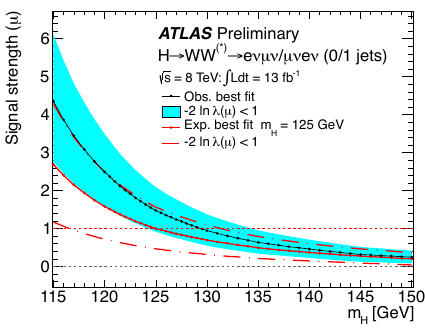
Figure 4. Fitted signal strength parameter ( µ ) as a function of m H for the low mass range [5]. The expected result for an injected signal with m H = 125 GeV (continuous red line) is included for comparison. The uncertainty on µ corresponds to the two cross- ings at 2ln λ ( µ ) = −